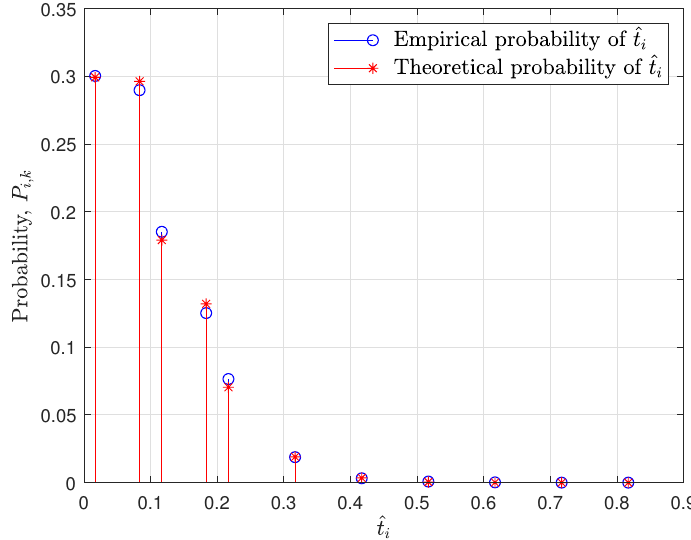
Figure 3. Plotting empirical probability P i , k with complex Gaussian distributed samples and theoretical probability by (17) on ˆ t i . ˆ t i is 0.45 and F 0 ( ˆ t i ) = 0.8167. For simulation, N equals to